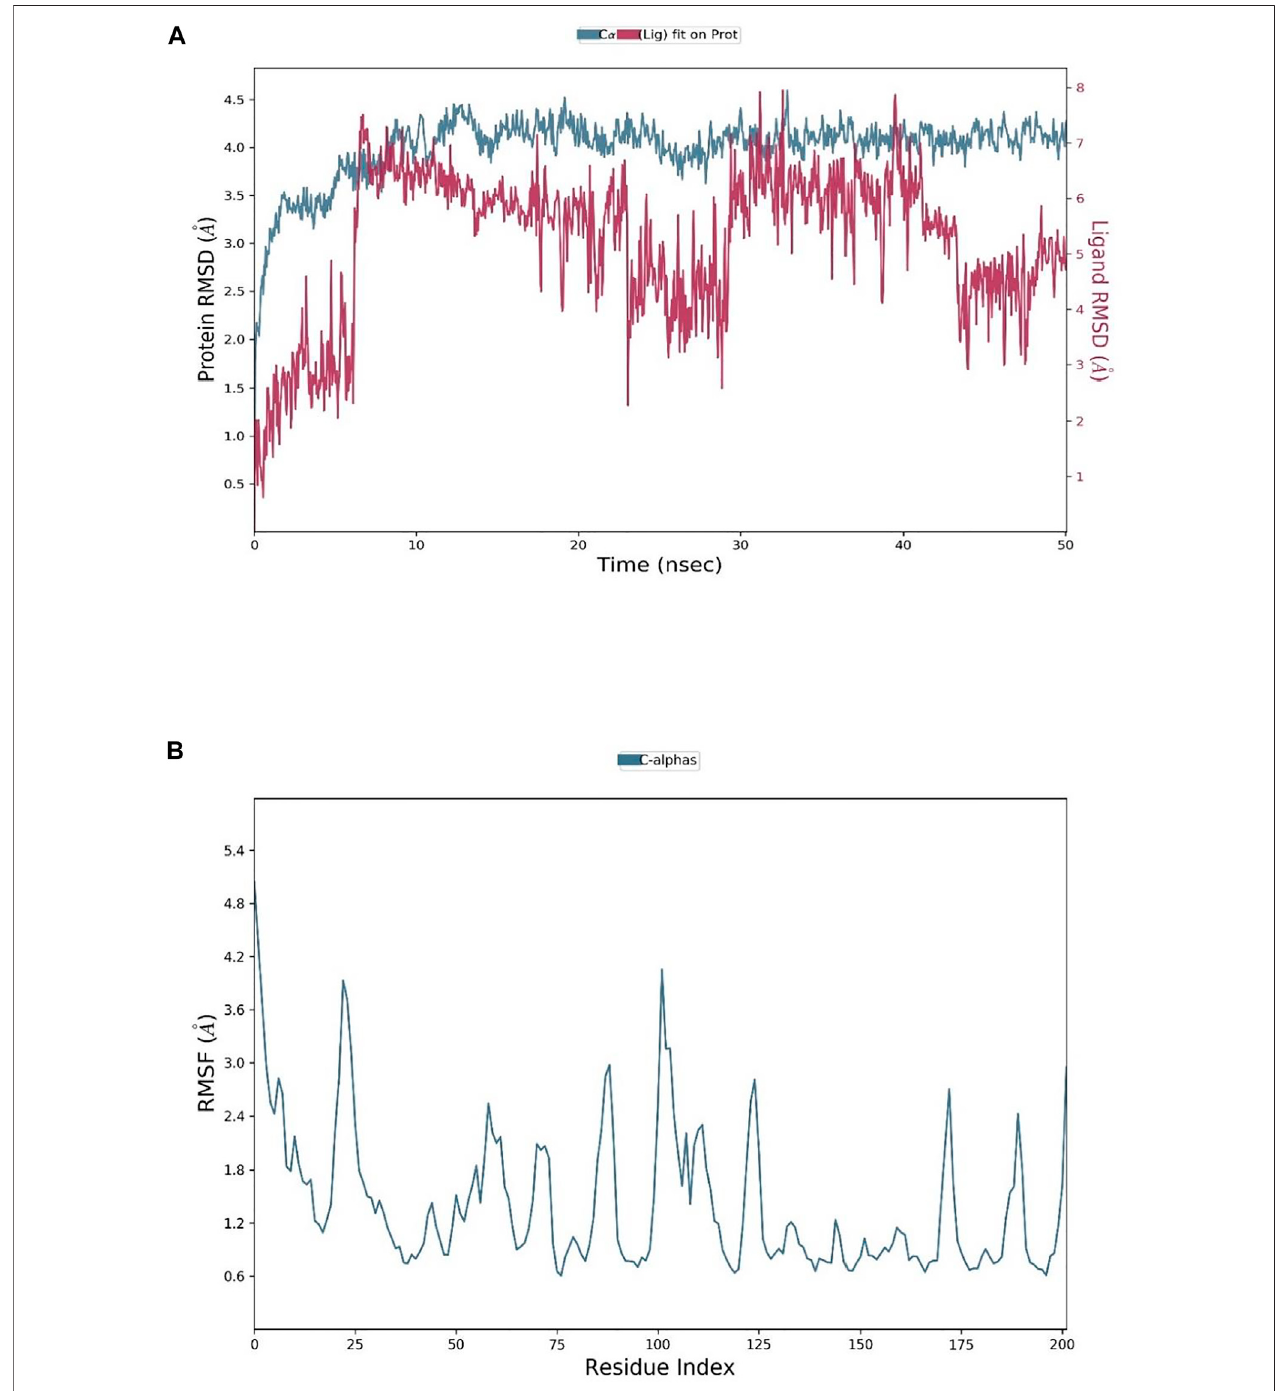
FIGURE 2 | (A) The RMSD plot for SARS-CoV-2 M protein and ZIN1722 complex, where the RMSDs of Protein backbone and the Ligands were calculated separately throughout the MD trajectory of 50 ns; (B) RMSF plot of the Protein chain in Ligand bound state.